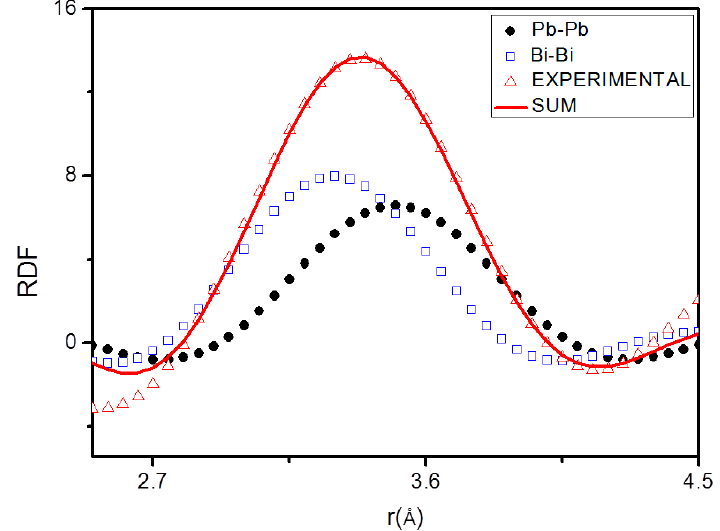
Figure 5. Fitting of the first radial distribution function (RDF) peak at 126 °C peak by means of the pair functions.